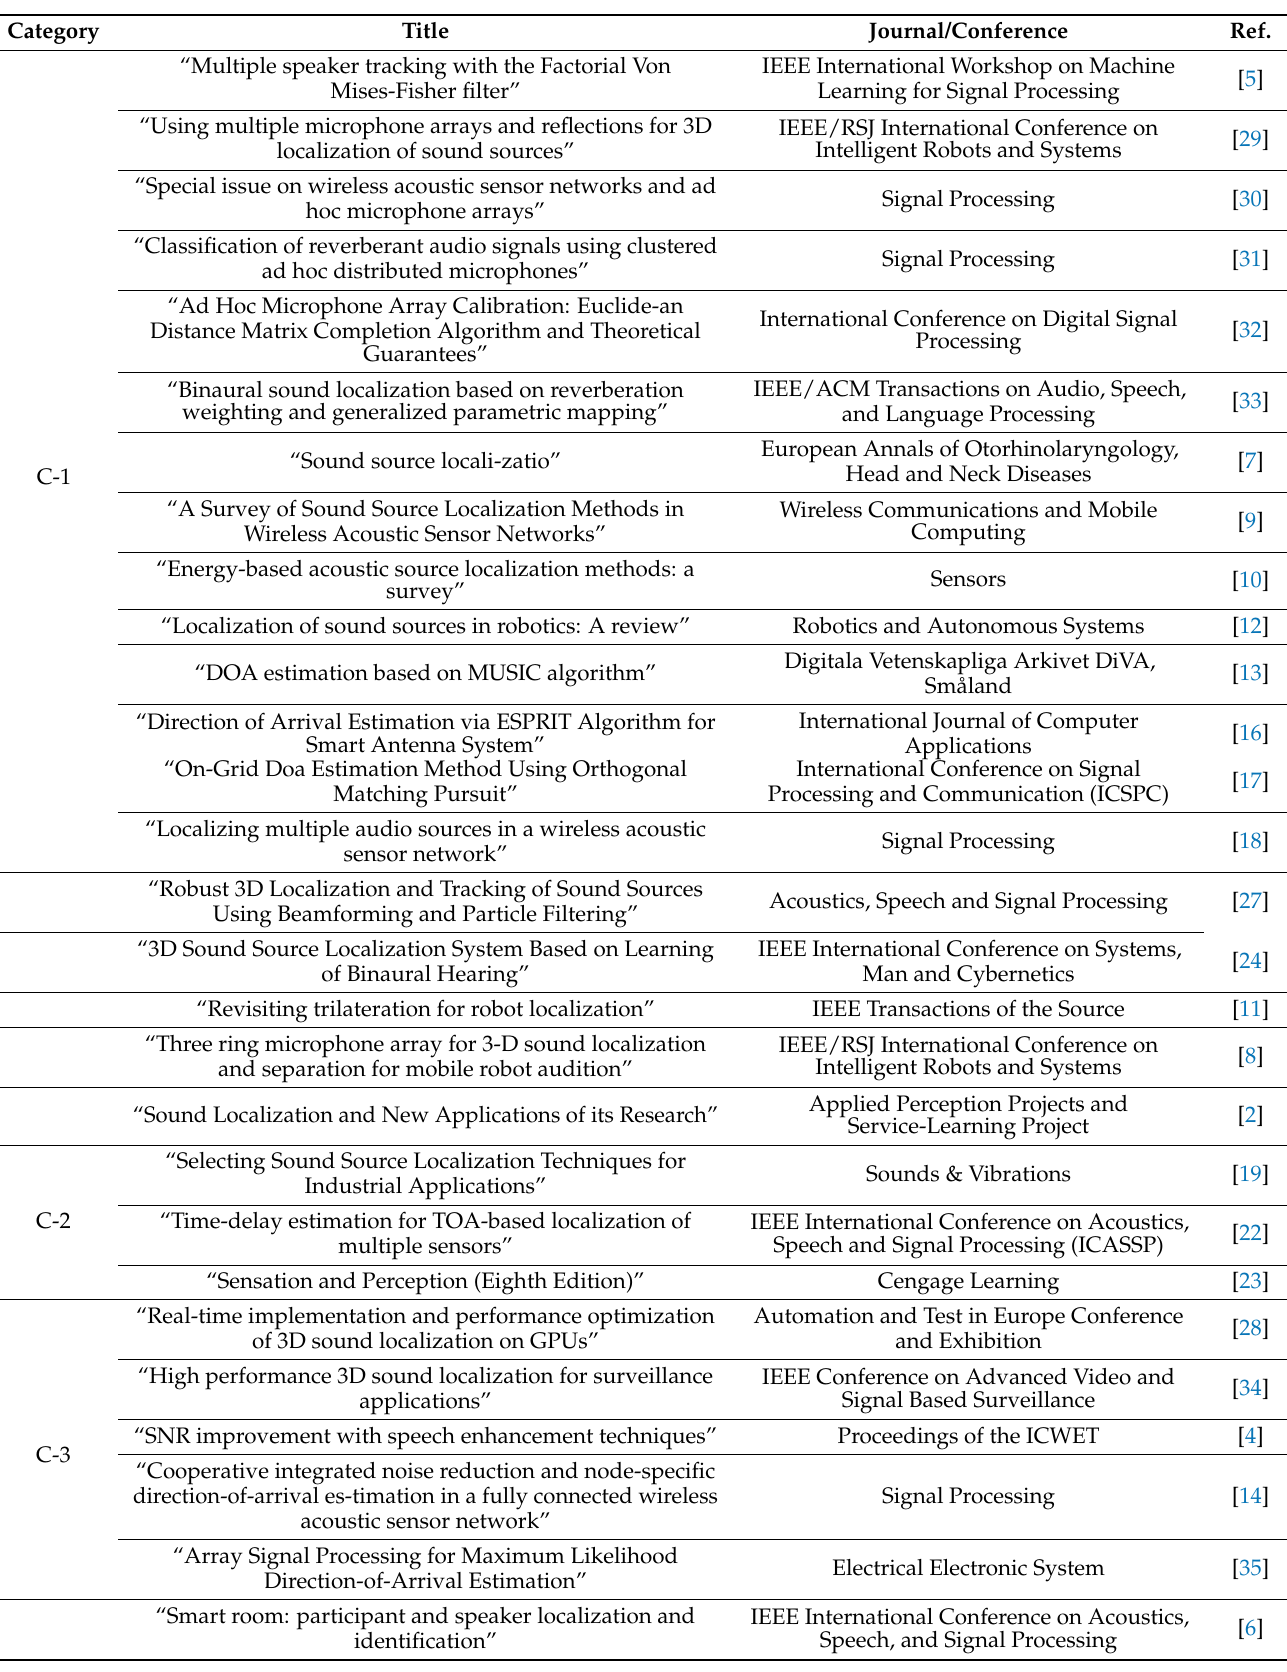
Table 2. Retrieved research